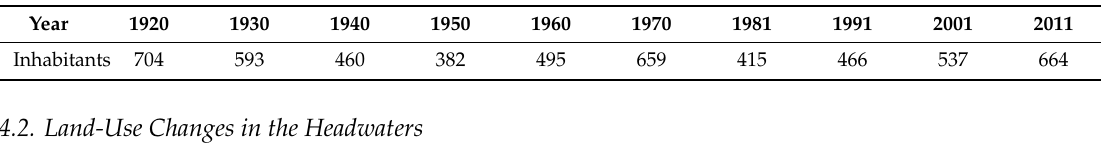
Table 4. Evolution of the population of the Rialp municipality since 1020